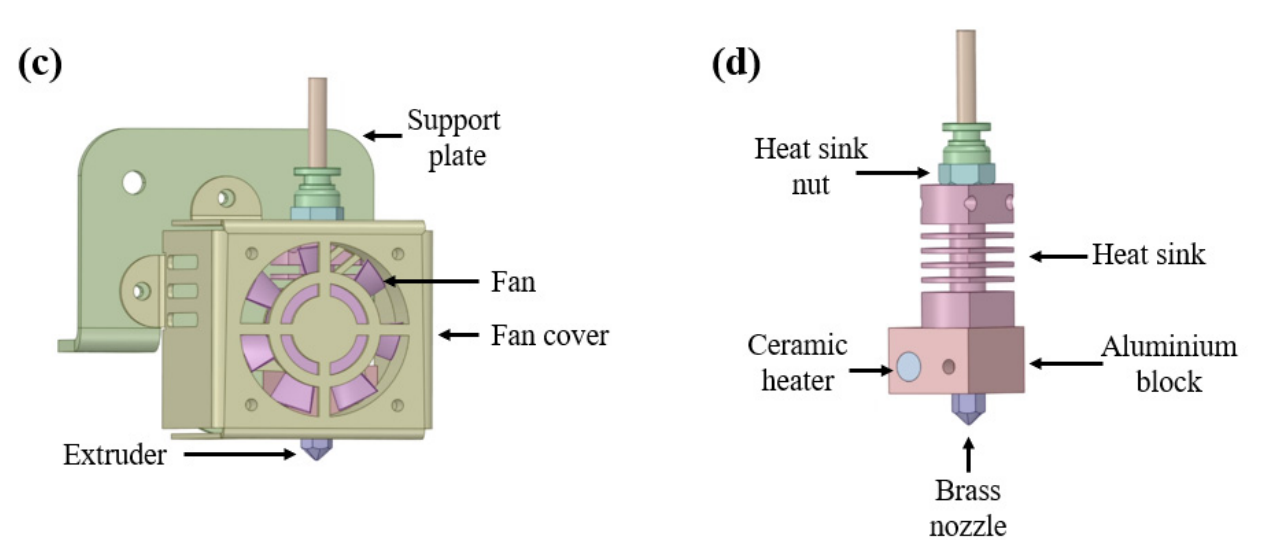
Figure 1. Anet ® ET4 Pro 3D printer: ( a ) Physical 3D printer; ( b ) Physical extruder assembly; ( c ) 3D model of the extruder assembly; ( d ) 3D model of the extruder.